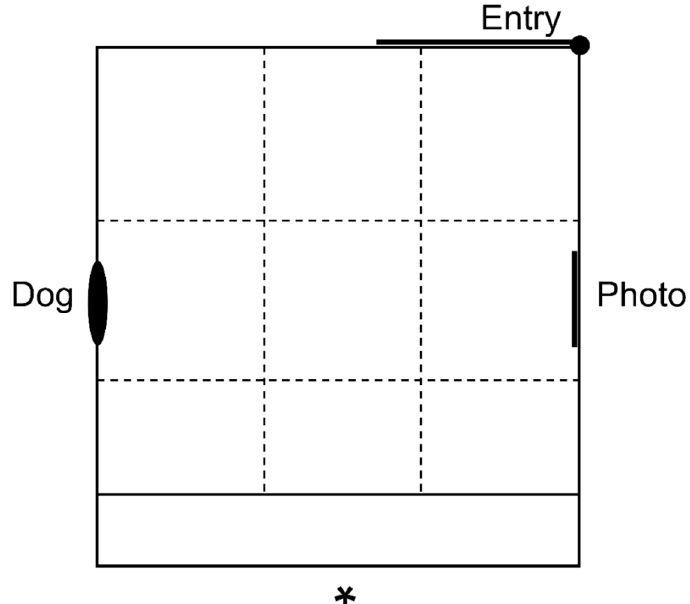
Figure 1. Diagram of the attention bias test arena. A dog was visible through a small window for 3 s at the beginning of the test, then an opaque covering was lowered over the window and the dog was removed. ‘*’ denotes the position of a camera and hidden observer, located on the second story of an adjacent building. External walls of the arena were covered in opaque matting 1.8 m high. A small section within the arena was fenced o ff to prevent sheep moving into the corners out of view of the camera. The accessible area of the arena was 4 × 4.2 m. The dashed lines represent the position of a 3 × 3 grid overlaid on video footage for calculation of zone related behaviors. Table 1. Ethogram of behaviors recorded during the attention bias test [24].